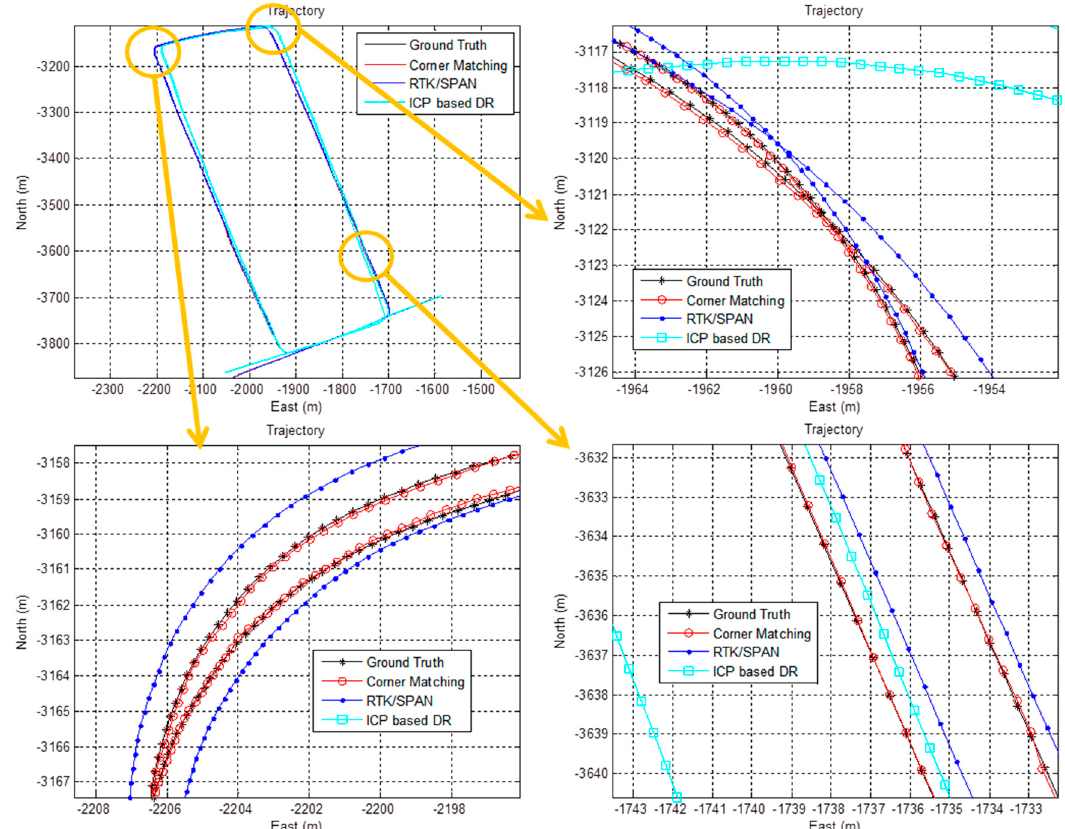
Figure 15. Vehicle trajectory for each case.